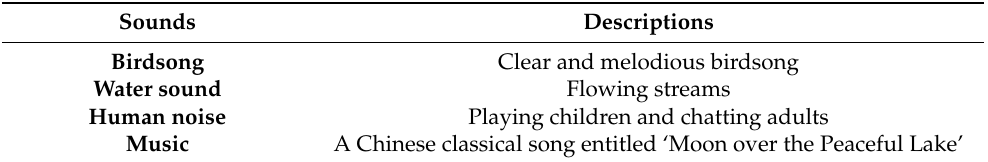
Table 1. Descriptions and sources of each sound type.